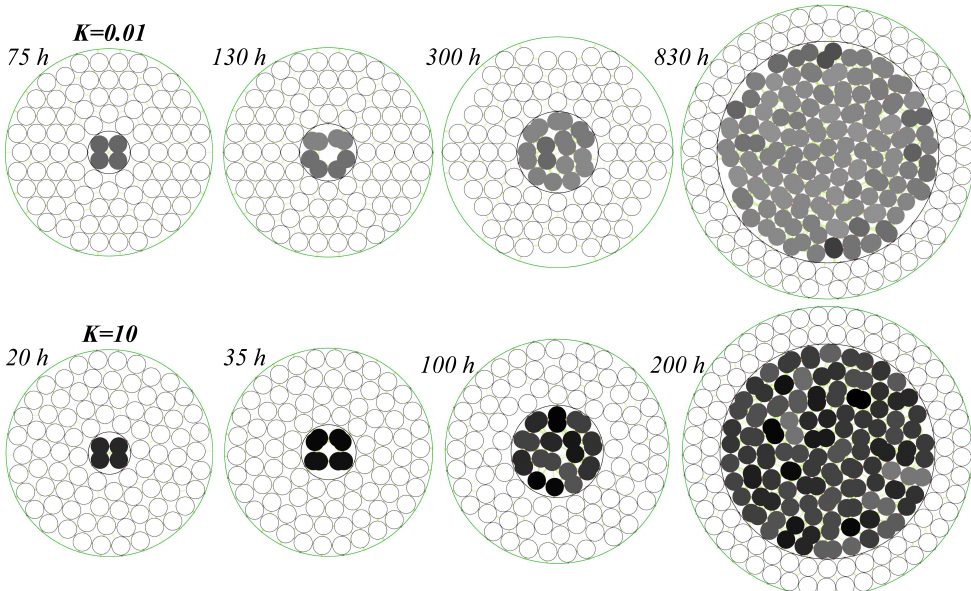
Figure 6. Snapshots of encapsulated tumor growth in tissue without accounting for nutrients at the designated times at k N = 200, k T = 80, and designated values of K , with other parameters values from the basic set (see Tables 1 and 2). The colors of the tumor cells correspond to their speed of divergence v div , with lighter cells dividing more slowly.